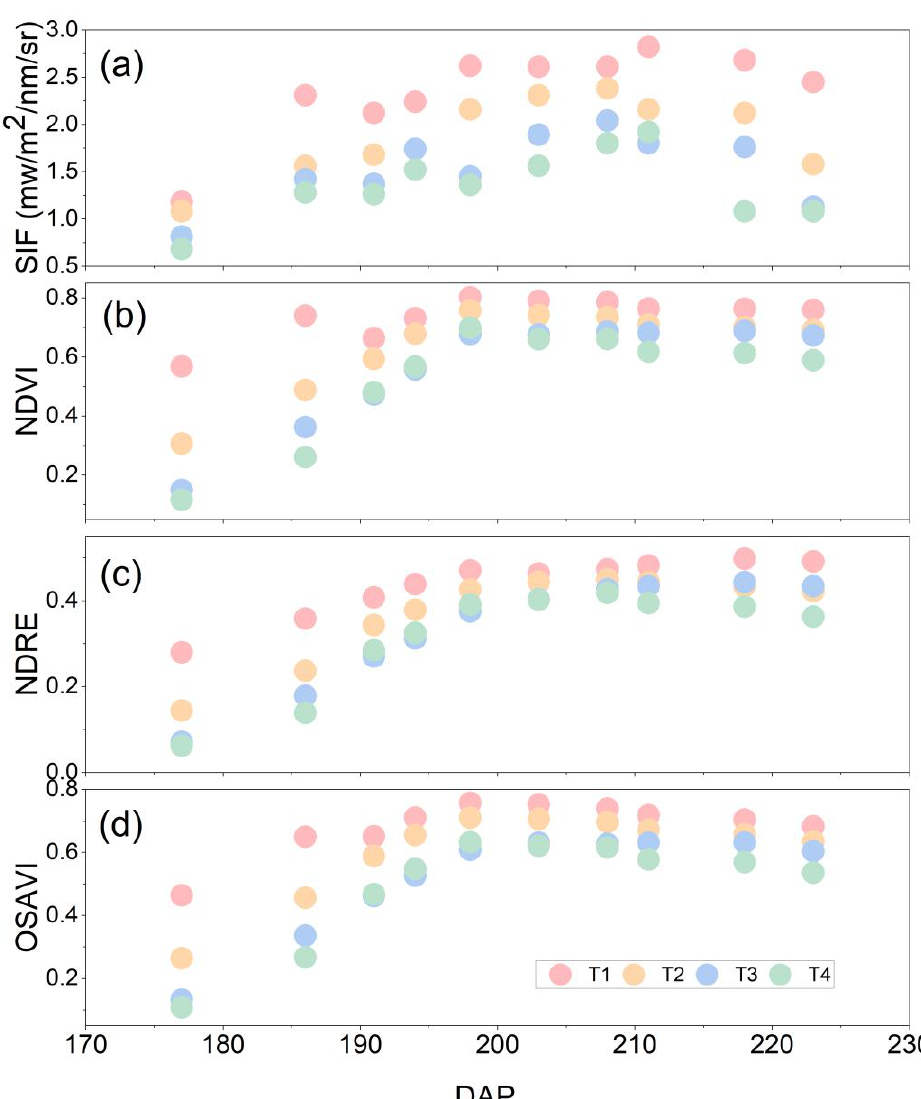
Figure 12. The seasonal changes of ( a ) SIF, ( b ) NDVI, ( c ) NDRE and ( d ) OSAVI under different water stresses. The red, yellow, blue and green solid circles represent well-watered, mild stress, moderate stress and severe stress, respectively. All values are averaged from 9:00 to 16:00. DAP means days after planting.